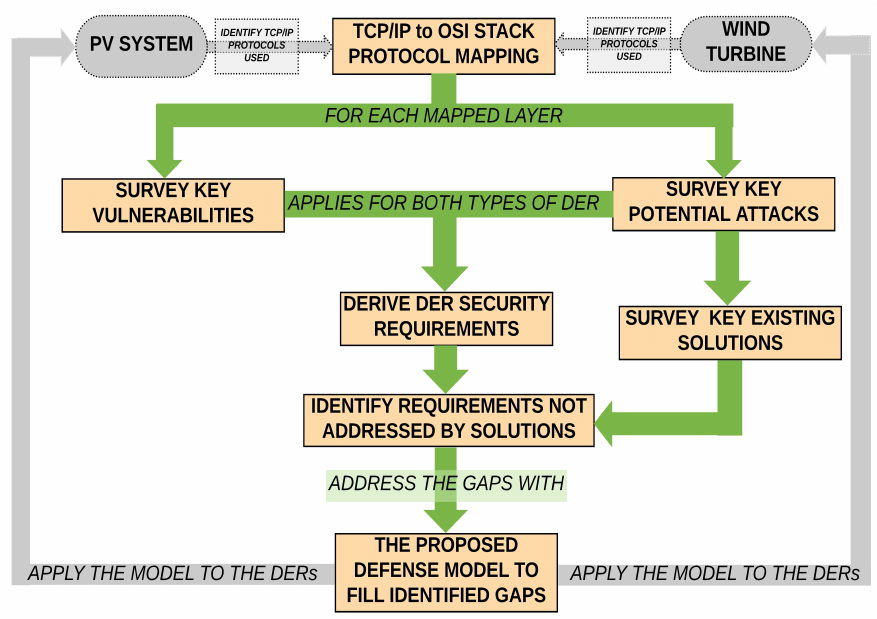
Figure 1. Flowchart showing the sequence of flow for the research effort.